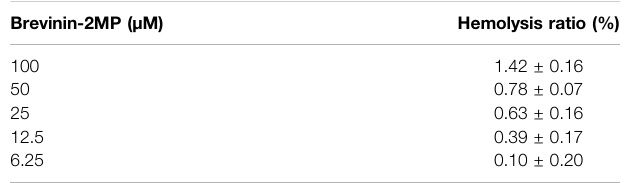
TABLE 3 | Cytotoxicity of brevinin-2MP.